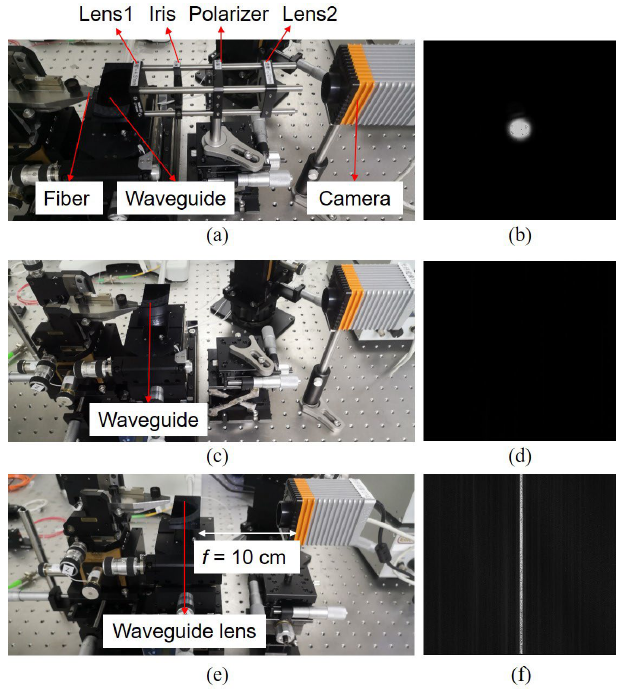
Figure 9. Photos of testing systems and captured photos of the optical fields of ( a , b ) a single-mode waveguide using free-space lenses, ( c , d ) a single-mode waveguide without any free-space lens, and ( e , f ) the WG lens chip without any free-space beam control.